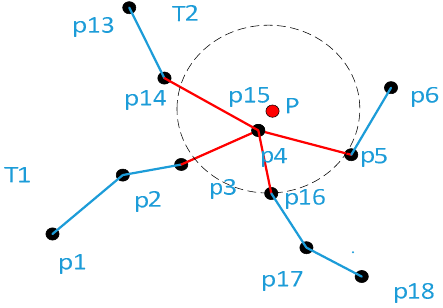
Figure 5. Schematic for determining a complex road network.